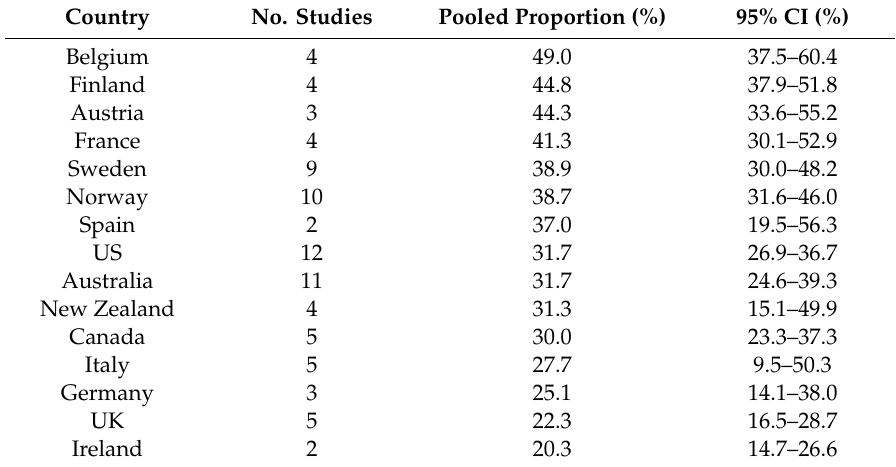
Table 3. Overall CNS drug use among care home residents by countries.